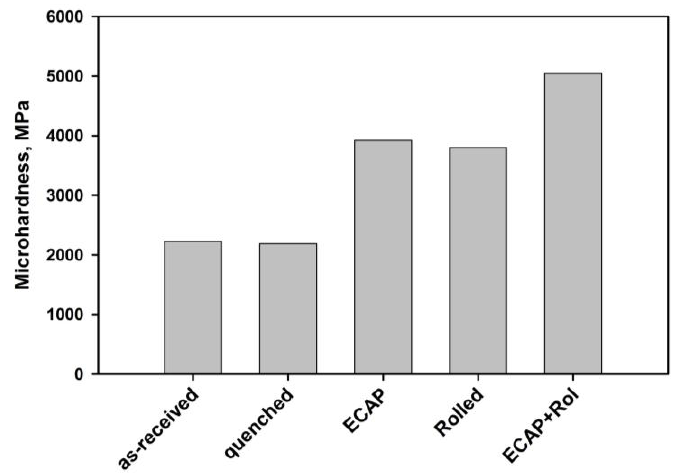
Figure 6. Microhardness of the austenitic steel after different types of processing.